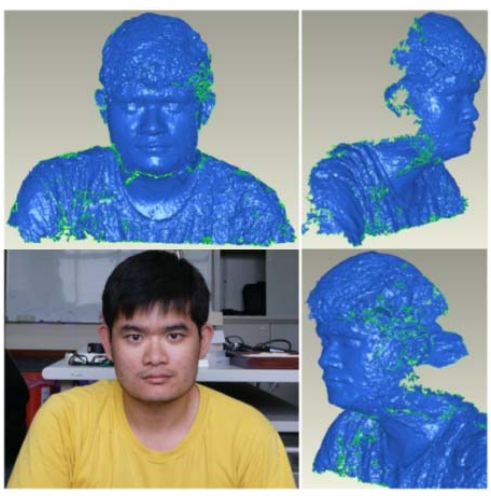
Figure 16. Human model generated by the proposed